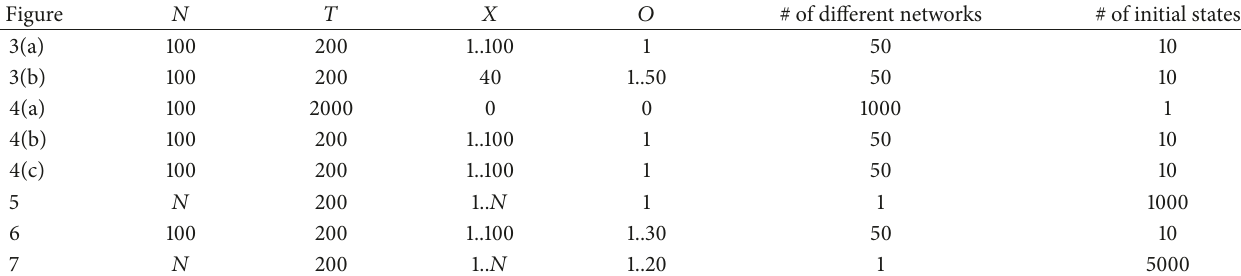
Table 1: Parameter settings for experiments.